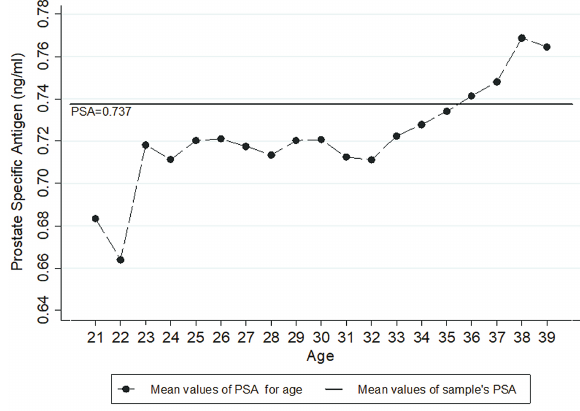
Figure 4 - Graphic model of the mean values of PSA according to age.